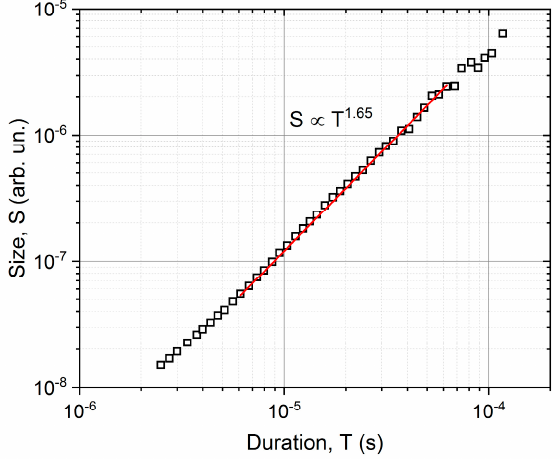
Figure 9. S versus T γ function, fitted in the range of the average avalanche shape functions, resulting γ = 1.65, which is in very good agreement with the γ value obtained from the fit of the average avalanche shapes.